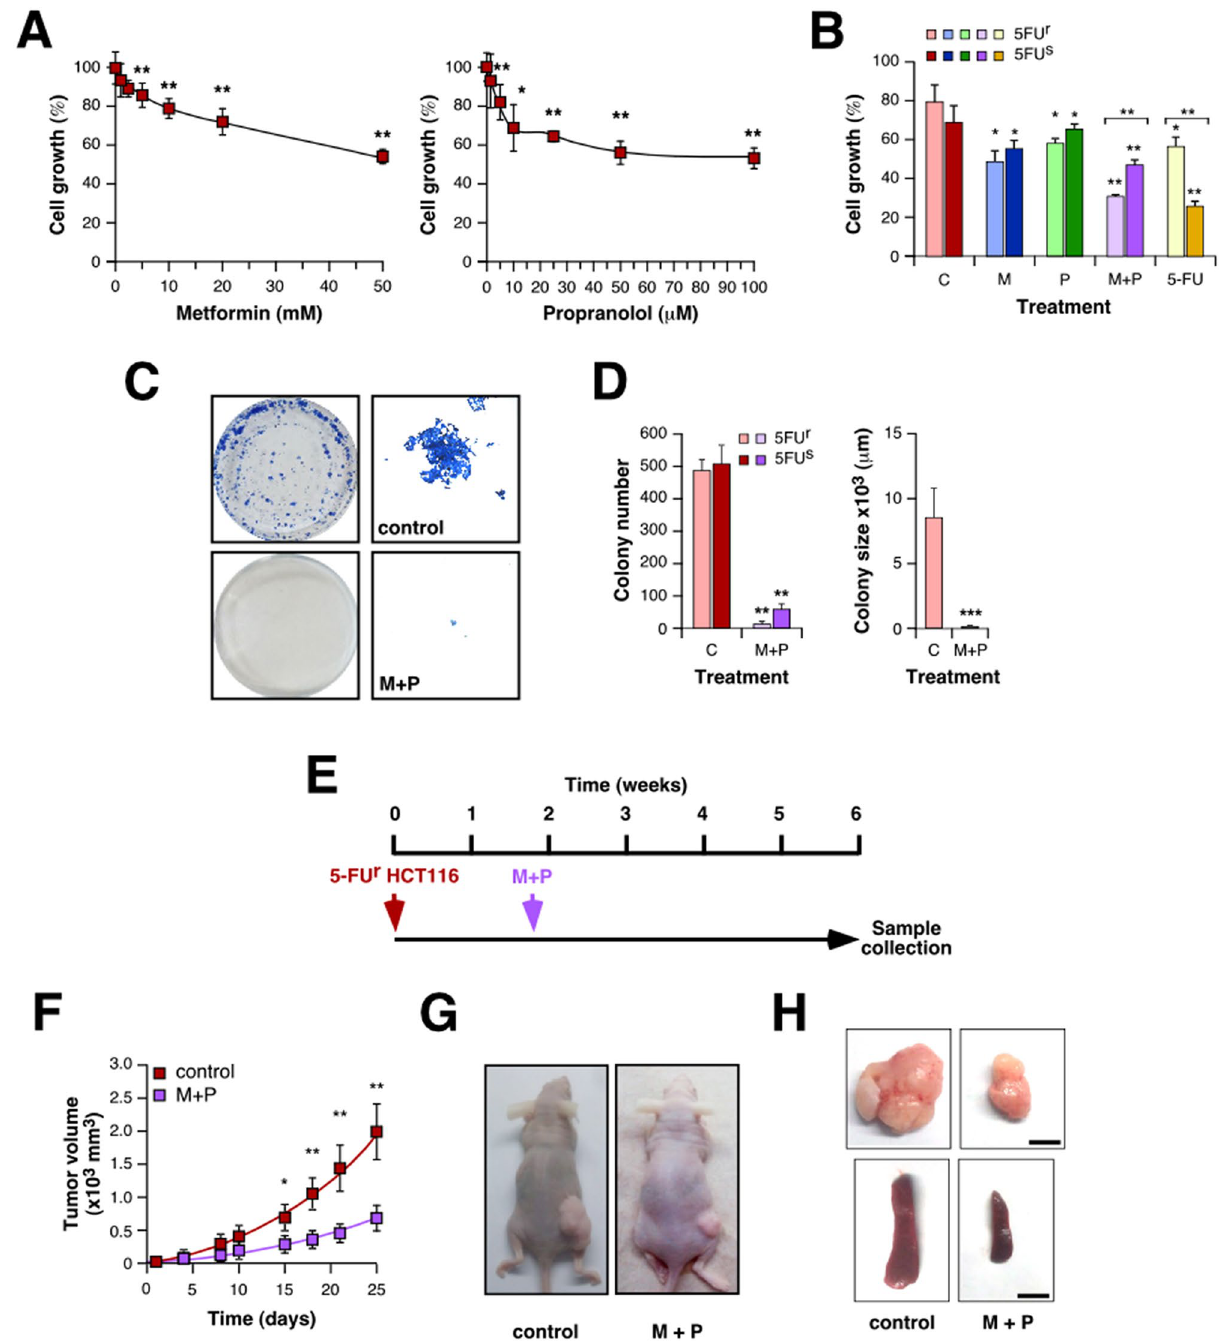
Figure 5. Combination of M + P prevents growth of 5-FU-resistant CRC cells. ( A ) 5-FU resistant HCT116 cells were cultured in the presence of the indicated doses of Met (left) or Prop (right) during 36 h. The number of living cells was estimated by tetrazolium salts reduction method (n = 3). ( B ) 5-FU sensitive (5FU s ) and resistant (5FU r ) HCT116 cells were cultured in the presence of Met (M, 2.5 mM) Prop (P, 2.5 µM), a combination of both or 5-FU (5 µM) as described before. ( C , D ). 500 cells were cultured in the presence of M + P during 8 days. Colonies were stained ( C ) in order to allow quantification ( D ). Colony size for 5-FU resistant cells was estimated ( D , right panel). ( E ) Scheme of the xenographic model used in this section. ( F ) Immunodeficient mice were subcutaneously challenged with 5-FU resistant HCT116 cells. Ten days later, treatment was added to the drinking water. The tumor size was measured biweekly with a caliper and volume estimated (time = 0 indicates the beginning of M + P treatment). At the end of the experiment, animals were sacrificed for necropsy ( G , H